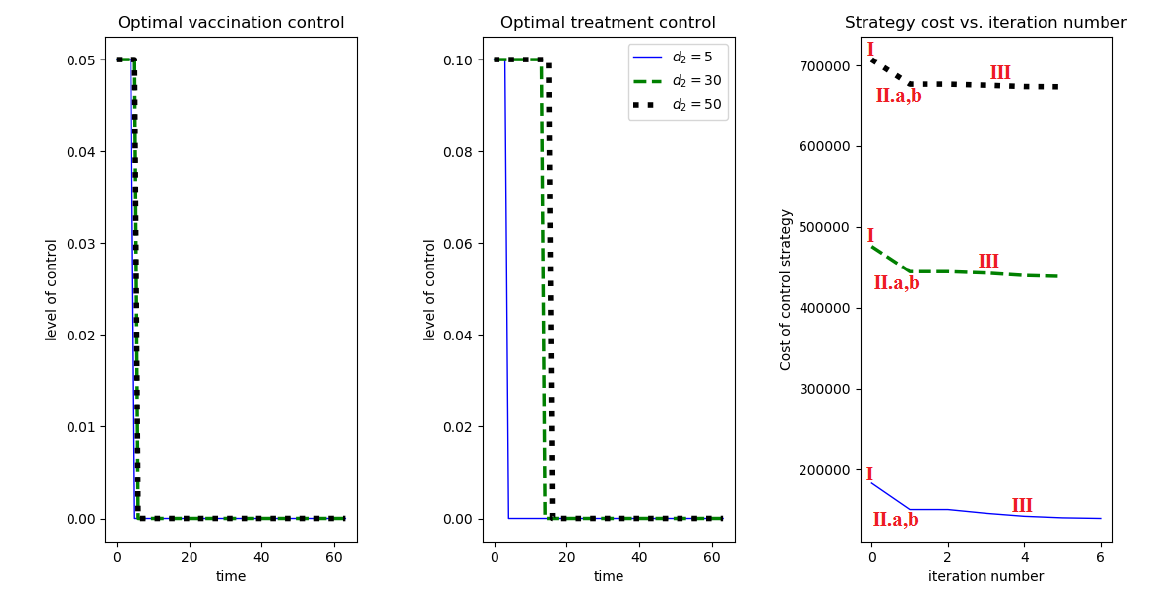
Figure 13. Optimal vaccination, treatment controls and strategy cost for different values of d 2